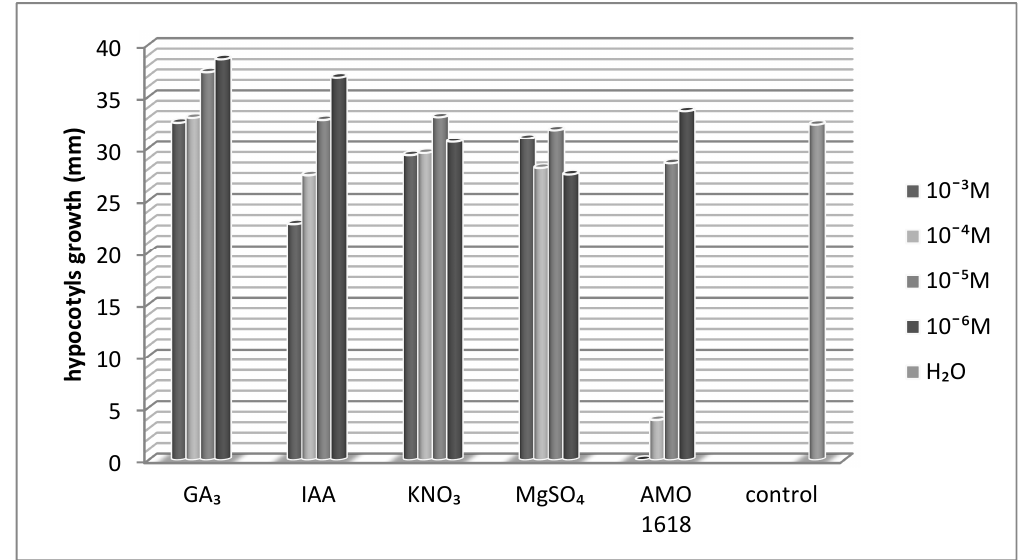
Figure 3. T. aestivum hypocotyls growth under the influence of plant growth regulators and inhibitor AMO